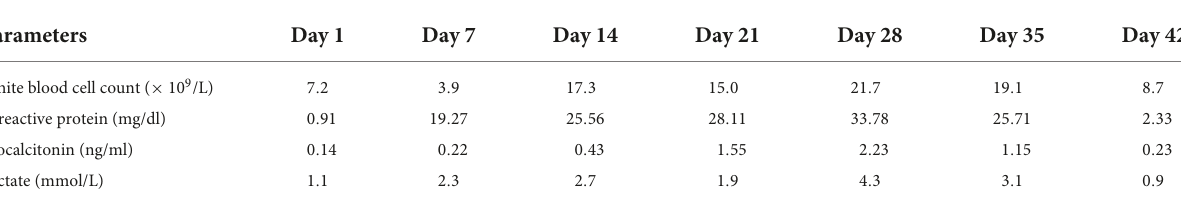
TABLE 1 Range of infective markers during ICU